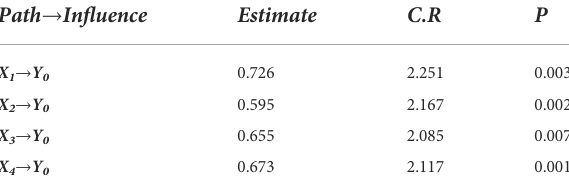
TABLE 5 Path parameter estimation. Path → In fl